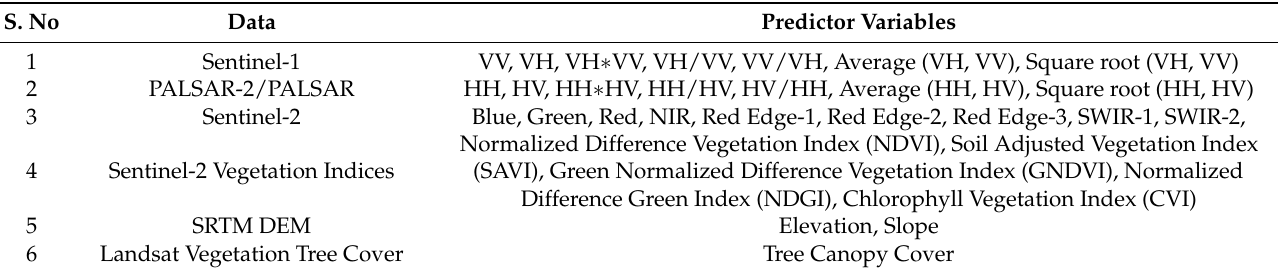
Table 3. Predictor variables used to run the